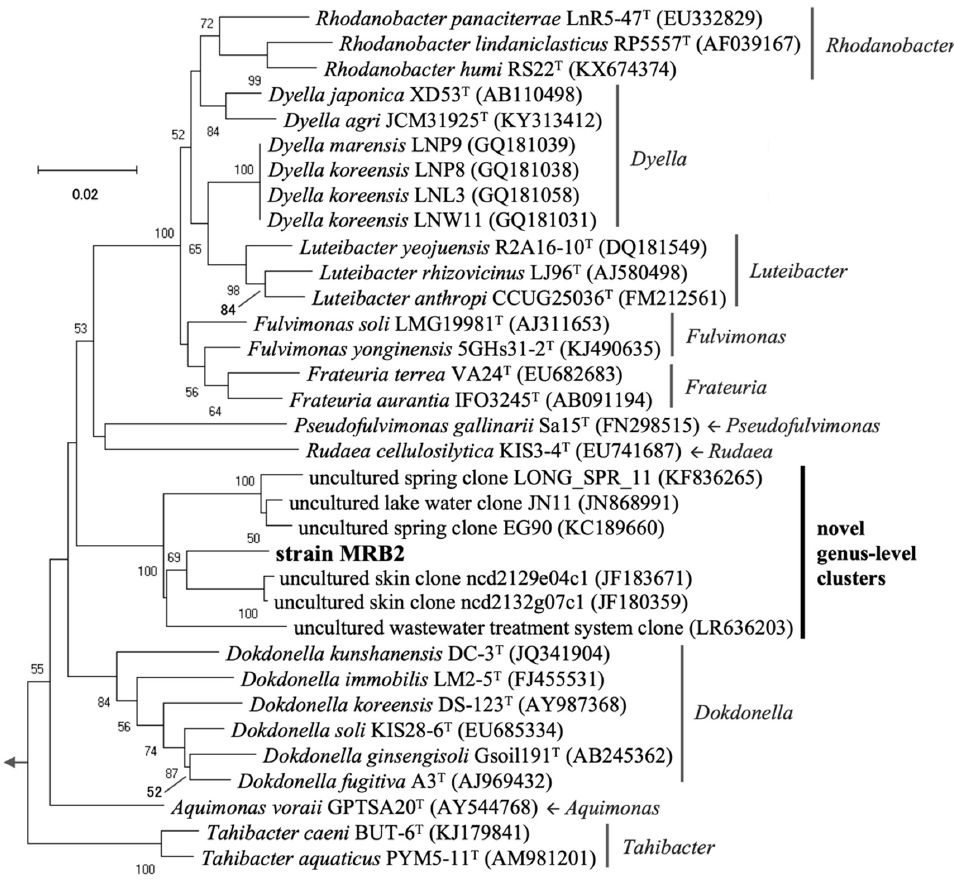
Figure 3. Phylogenetic tree based on near full-length 16S rRNA gene sequences from a novel strain MRB2 and its related type species, known plant growth-promoting bacteria (PGPB), and environ- mental sequences. The evolutionary relationship in the family Rhodanobacteraceae (class Gammaproteobacteria) was inferred using the neighbor-joining method with the Kimura 2-parameter model. There were a total of 1257 positions in the final dataset. Pseudomonas aeruginosa ATCC10145 T was used as an outgroup. Accession numbers of nucleotide sequences registered in the DDBJ/ENA/NCBI databases are shown in parentheses. Bootstrap values >50% based on 1000 repli- cates are shown at the nodes. Scale bar, 0.02 nucleotide substitutions per site.